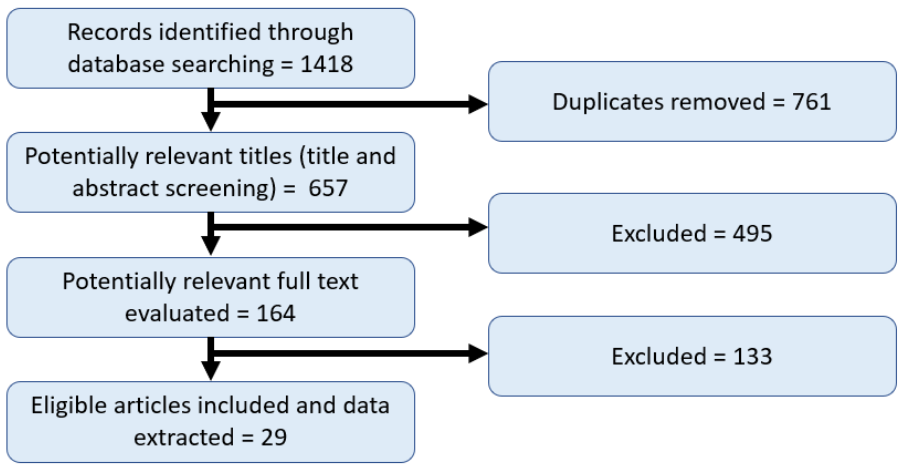
Figure 1. Literature review study selection flowchart.